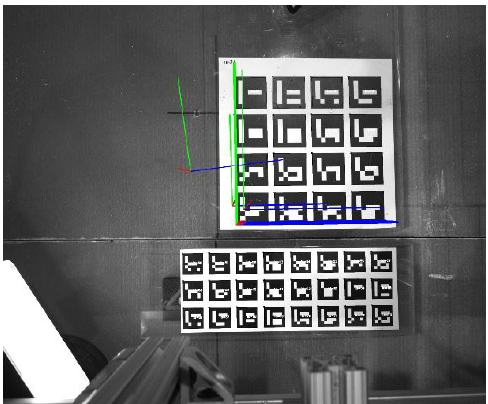
Figure 10. Convergence of the panelmarker pose to the referencemarker pose viewed fromthe gripper camera. The coordinate frames indicate the poses of the reference marker during the convergence while the panel marker is relatively stationary to the gripper camera.